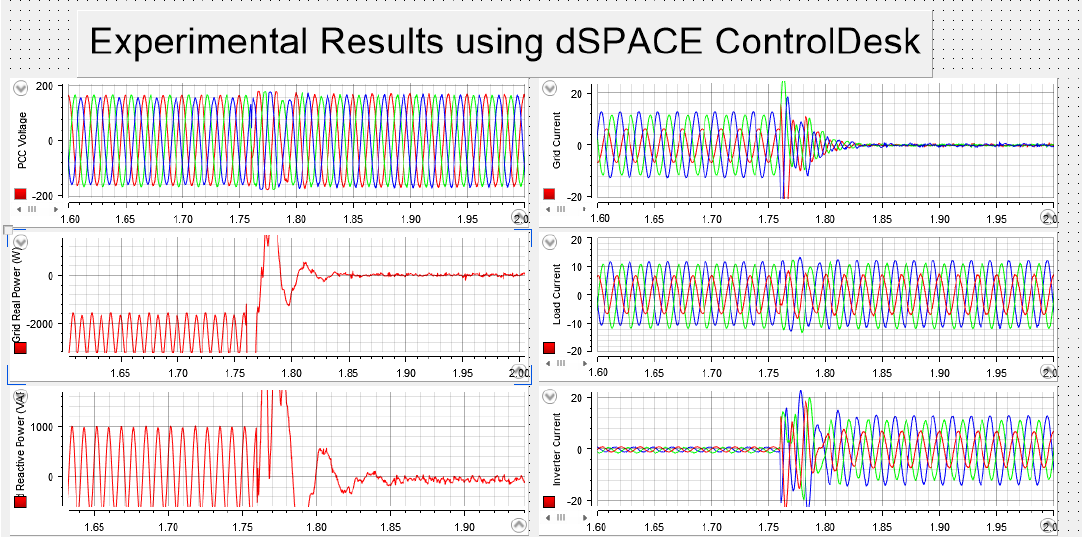
Figure 16. Hardware results using dSPACE Controldesk for real power = 0 W and reactive power = 0 var under balanced grid